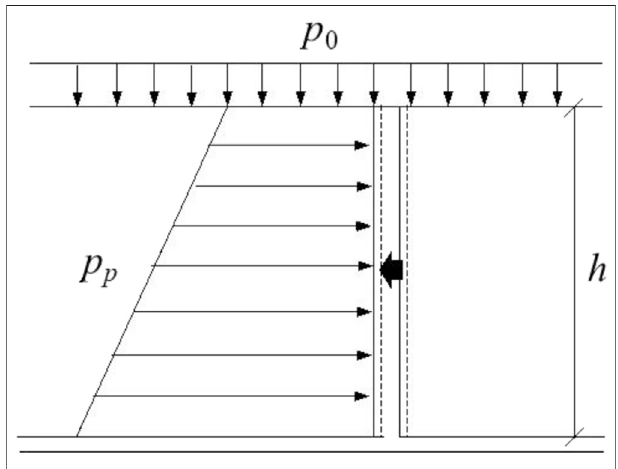
FIGURE 9 | The stress summation model.